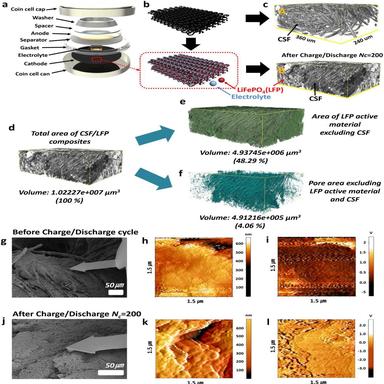
Analysis of LiFePO4/carbon fabric composites for applying lithium-ion energy storage. a The schematic of the coin cell. b The schematic of the only CSF (pristine) and the CSF/LFP composites applied to the coin cell. c Virtual cross-section photograph of the nondestructive 3D XRM of the only CSF (pristine) with 3 dimensional porous structure (top image, A). Virtual cross-section photograph of the structure of the CSF/LFP composites after charge/discharge Nc ¼ 200 (bottom image, B). d XRM image showing the to